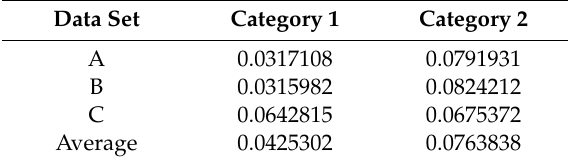
Table 5. Average moles of CO 2 produced per sample period for each data set.